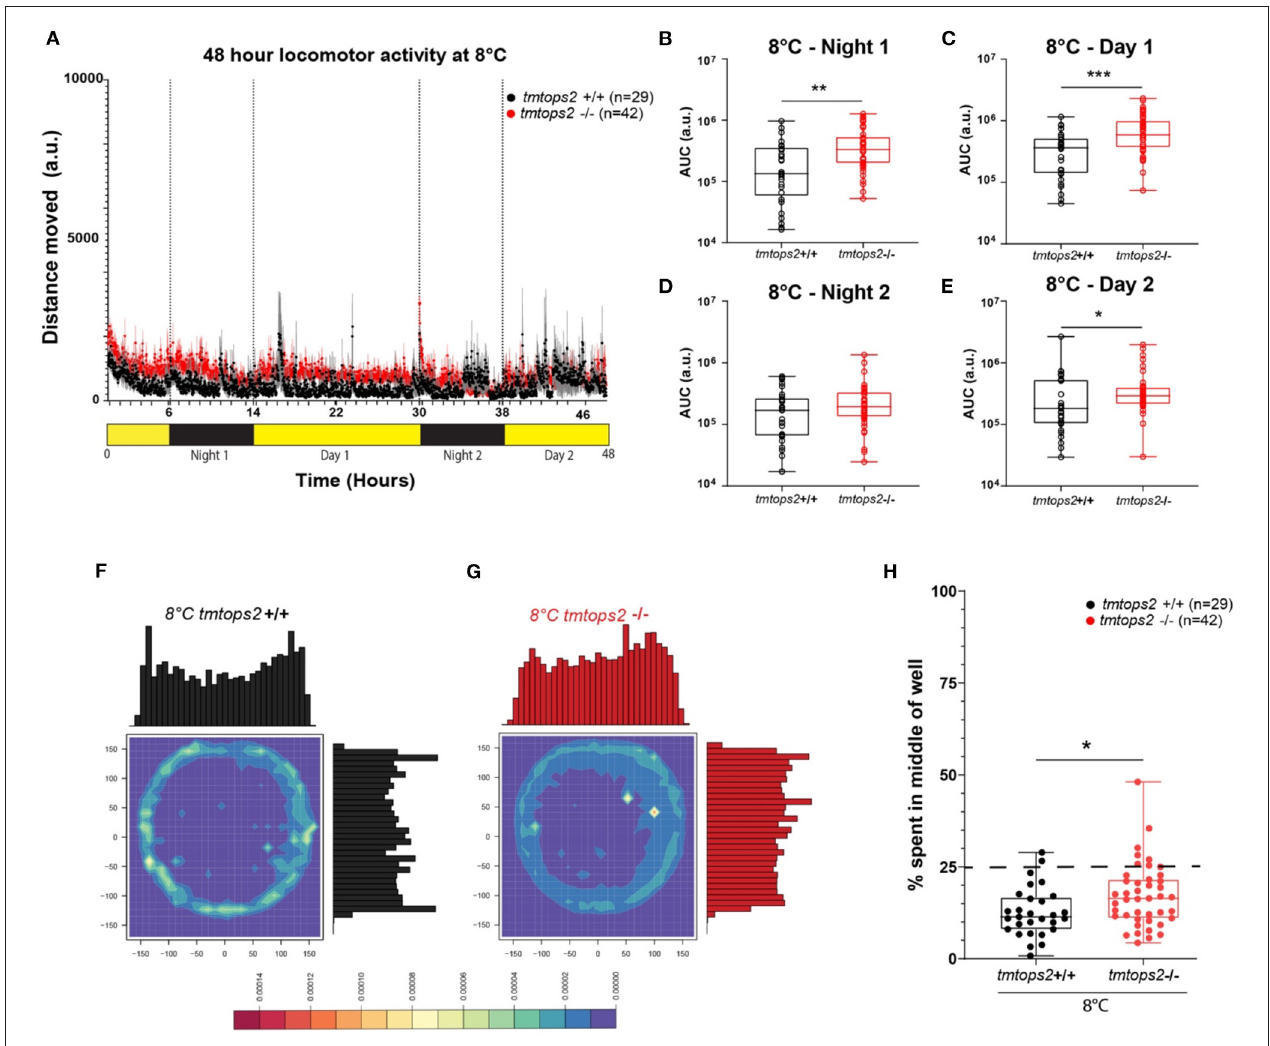
FIGURE 2 | Locomotor activity characterization at 8 ◦ C. (A) Average distance moved over the course of 48 h at 27 ◦ C. Each point represents the mean ( ± SEM) distance moved for the preceding 1 min. Yellow and black boxes along the x-axis represent light conditions. (B–E) Locomotor activity (measured as AUC) during each separate night and day period. n = 29 ( tmtopsin2 -related wild type) and n = 42 ( tmtopsin2 homozygous mut). (F,G) Heat plots and histograms showing the density of the binned position data points. (H) Box plots showing the percentage of frames located in the middle zone; each dot represents one biological replicate, i.e., one juvenile larva. n = 29 (wt) and n = 43 ( tmtops2 mut). *** p ≤ 0.001, ** p ≤ 0.01, * p ≤ 0.05. a.u.: arbitrary units; dashed line represents expected % if random. Data were collected from three to four experimental repetitions on different days, with up to 12 individual fish of each